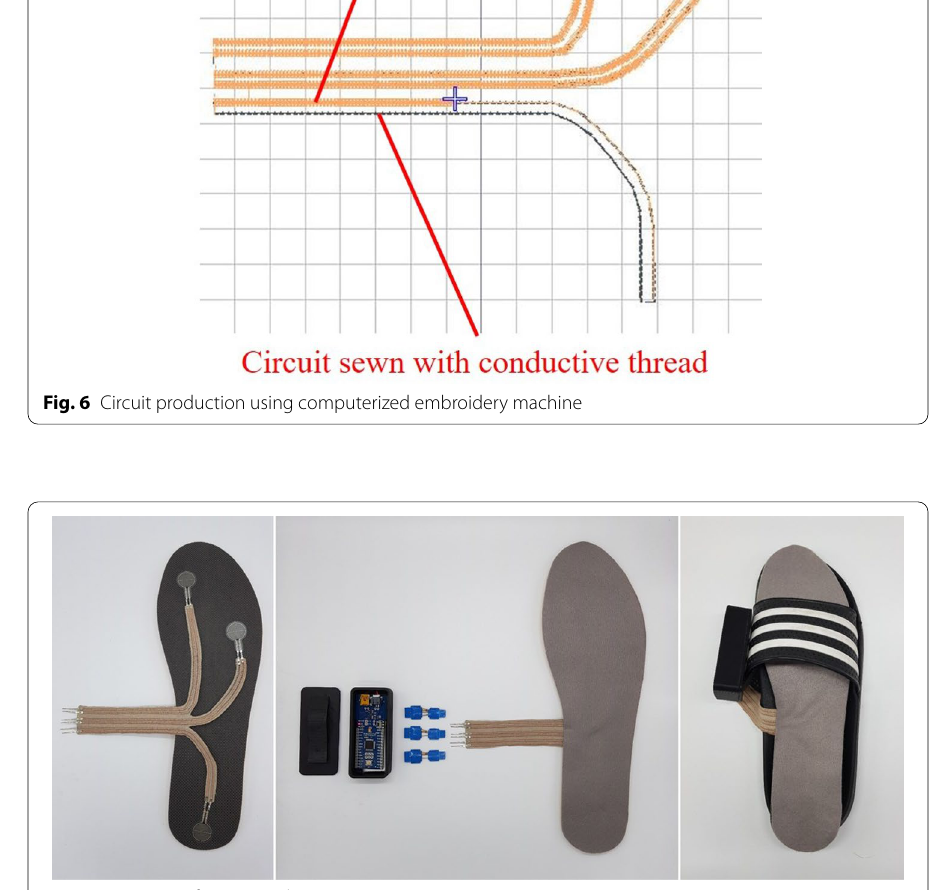
Fig. 7 Prototype of smart